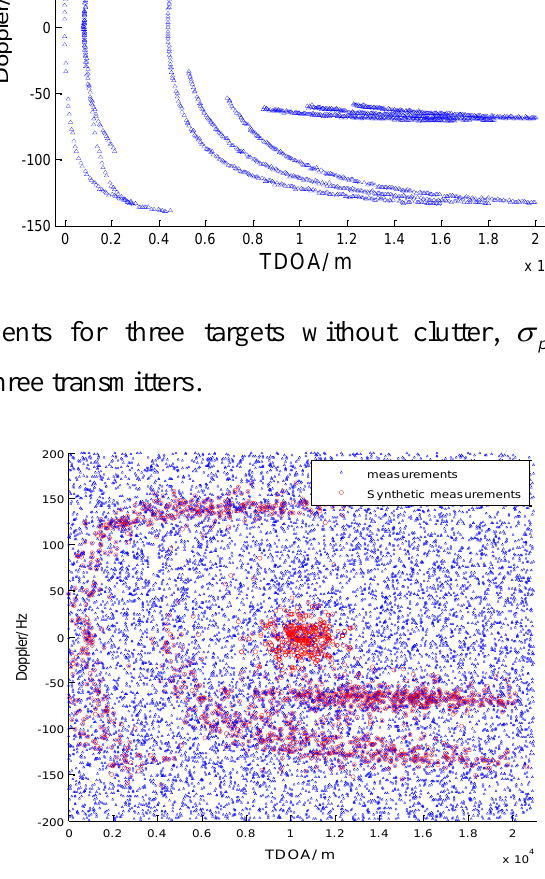
Figure 6. PMHTe synthetic measurements with clutter,